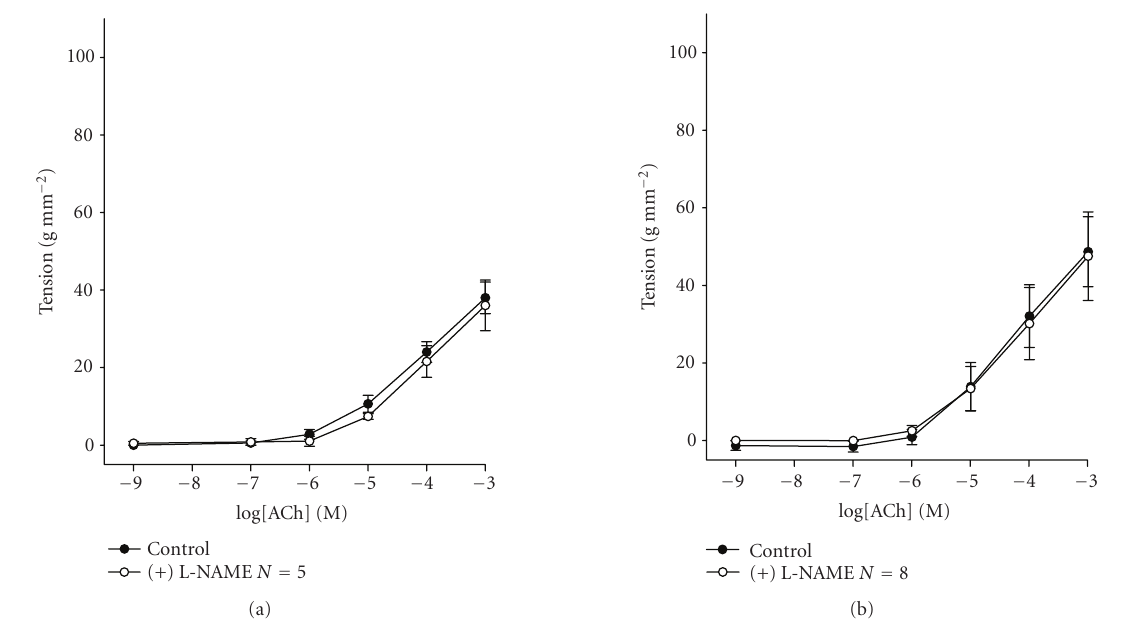
Figure 3: Concentration-e ff ect curves for acetylcholine, performed in Krebs solution with low calcium concentration, at an RT of 0.5 g (a) and 2.5g (b). Data are means and vertical lines show SE. N refers to the number of animals studied.